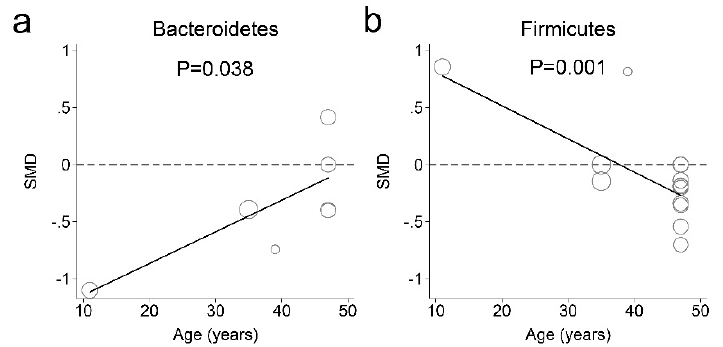
Figure 6. Association between age and the fecal microbiota abundance in obese and nonobese individuals. The participants’ mean ages were modeled using separate random-effects meta-regression models. The fecal microbiota (( a ) Bacteroidetes; ( b ) Firmicutes) abundance levels were compared between obese and nonobese individuals. The Y axes indicate a standardized mean difference (SMD). Each circle represents a study and the size of the circle reflects the influence of that study on the model. The circle size is inversely proportional to the standard error of that study. The solid lines represent the weighted regression lines based on variance-weighted least squares.